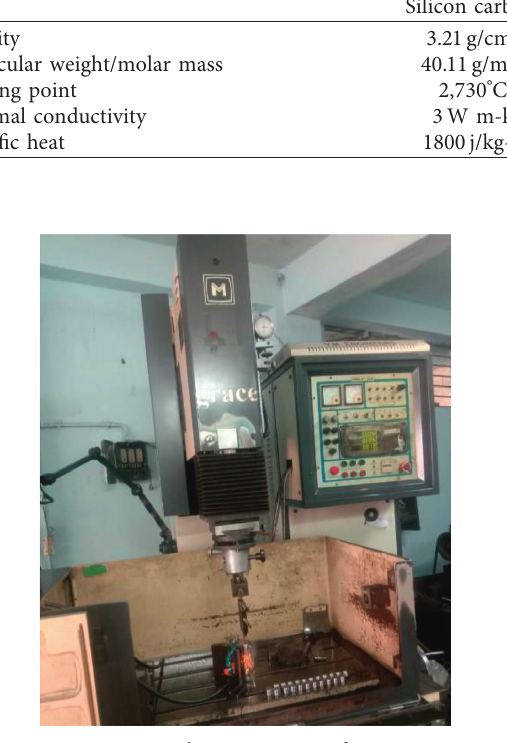
Figure 2: Machining process of PMEDM. Table 4: Input process parameters and their levels.